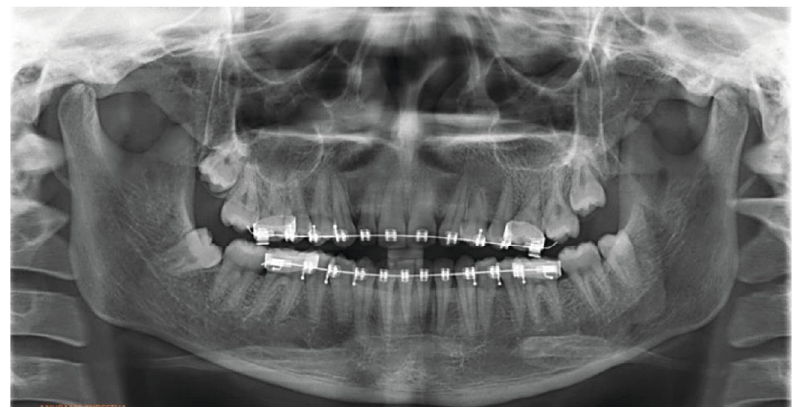
Figure 9: Orthopantomogram at the end of